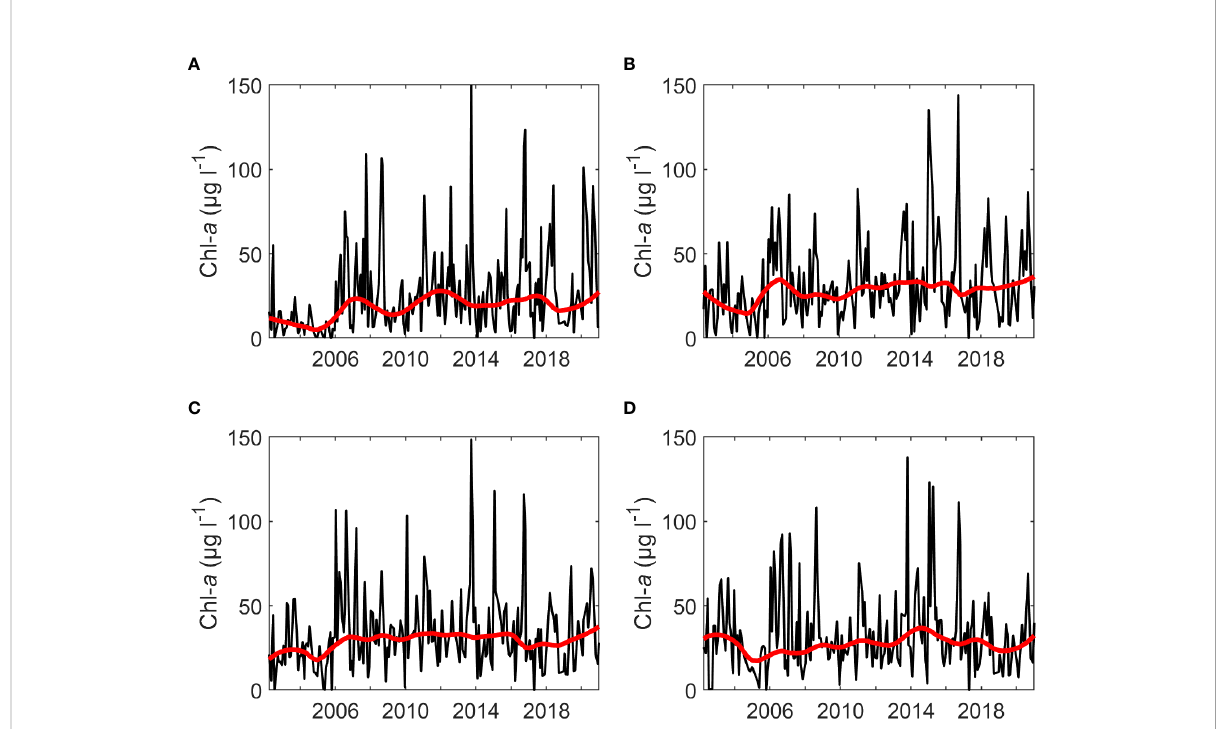
FIGURE 2 Monthly SWMP chl- a values (black) and fi tted rloess curves (red) for the (A) Fish River, (B) Magnolia River, (C) Middle Bay, and (D) Weeks Bay